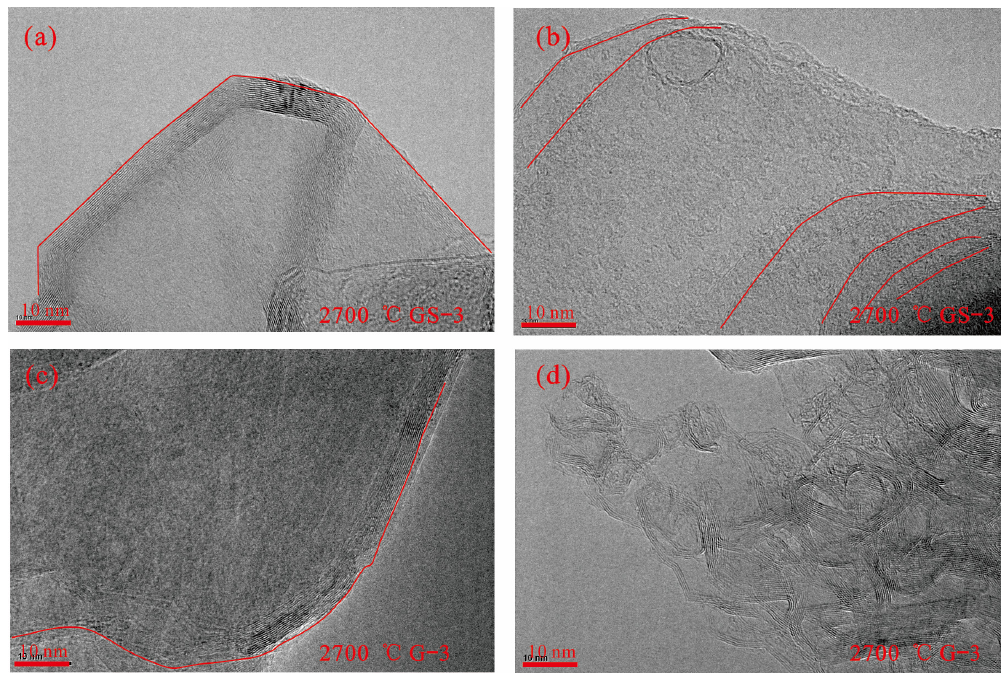
Figure 3. HRTEM characteristics of G/GS at 2100 °C–2400 °C. ( a ) 2100 °C GS-1; ( b ) 2100 °C G-1; ( c ) 2400 °C GS-2; ( d ) 2400 °C G-2.